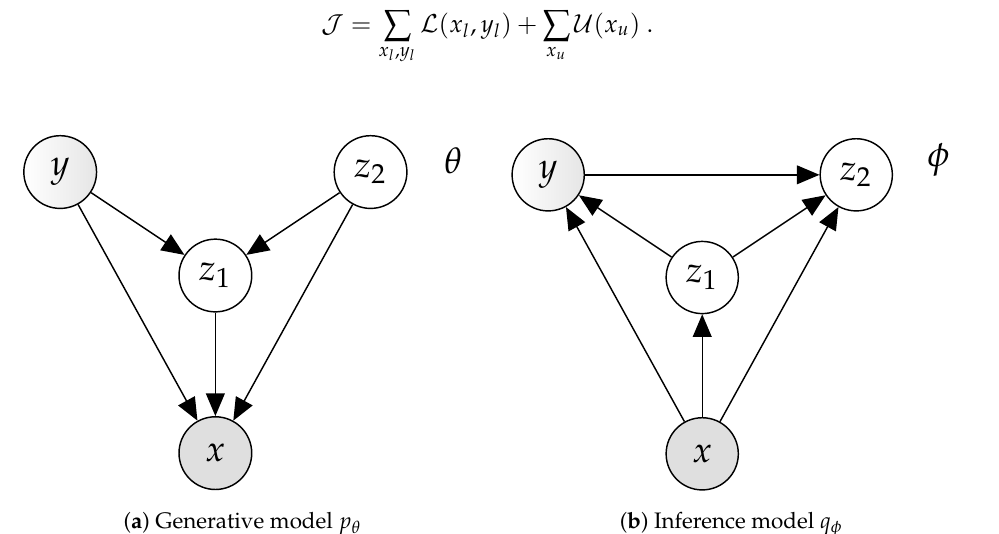
Figure 2. The graphical model of the SDGM for semi-supervised learning [14]. The model is defined by two continuous latent variables, z 1 and z 2 , a partially observed discrete latent variable y , and a fully observed input x . ( a ) The generative model and ( b ) the inference model, also known as the variational approximation. Each union of incoming edges to a node defines a densely connected deep neural network.